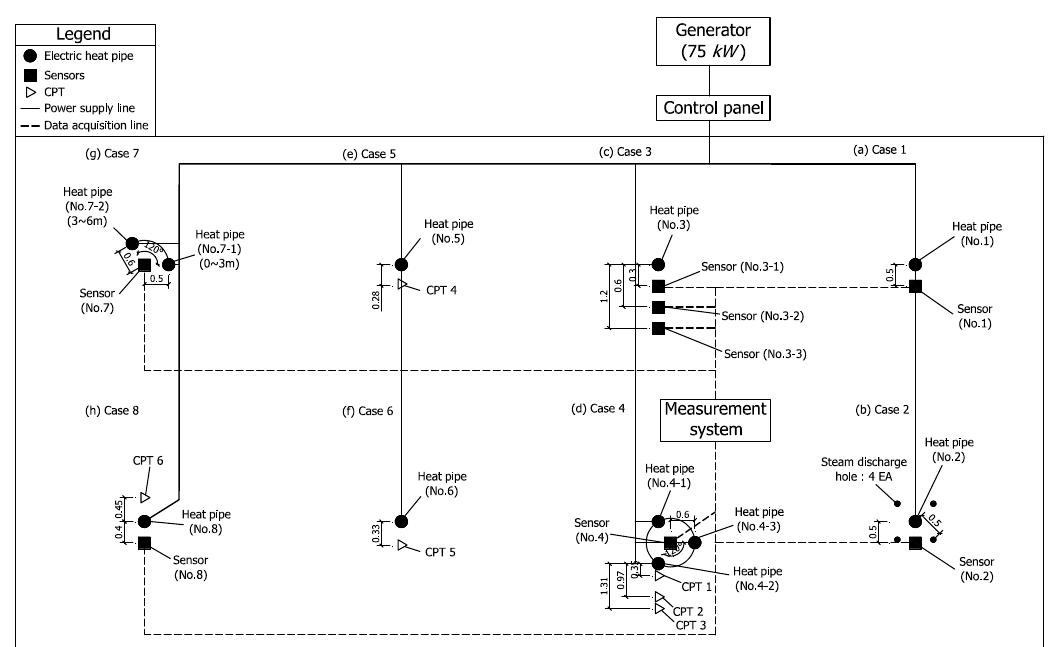
Figure 6. The conceptual diagram of the field experiments performed in this study.